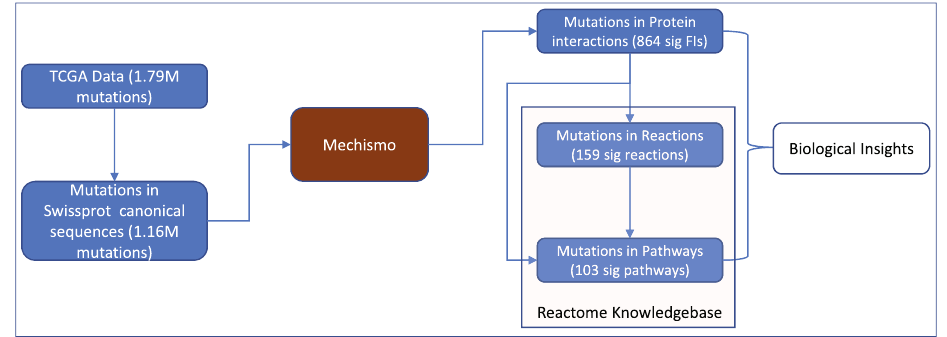
Figure 1. An overview of a multi-scale analysis approach for protein structural variants caused by cancer somatic mutations collected in the TCGA